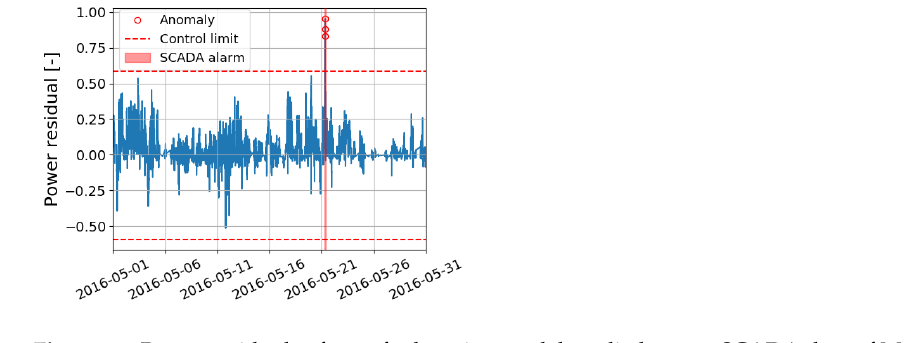
Figure 26. Power residuals of transfer learning model applied to raw SCADA data of May 2016. Table 3. Detection performance of standalone SCADA-based ANN and transfer learning ANN on one month of raw SCADA